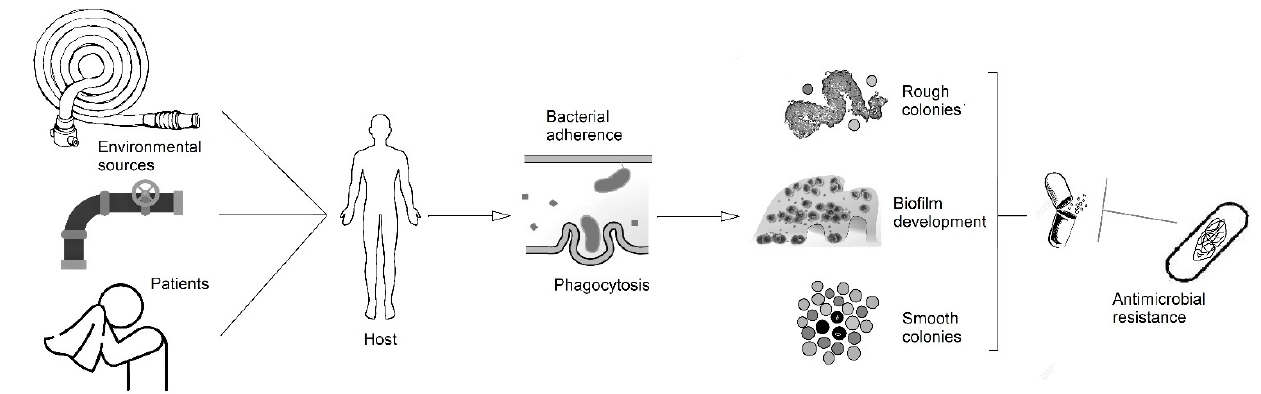
Figure 1. Scheme of the pathogenesis of M. abscessus disease from the potential sources to the development of biofilms, intracellular survival, and antimicrobial resistance.